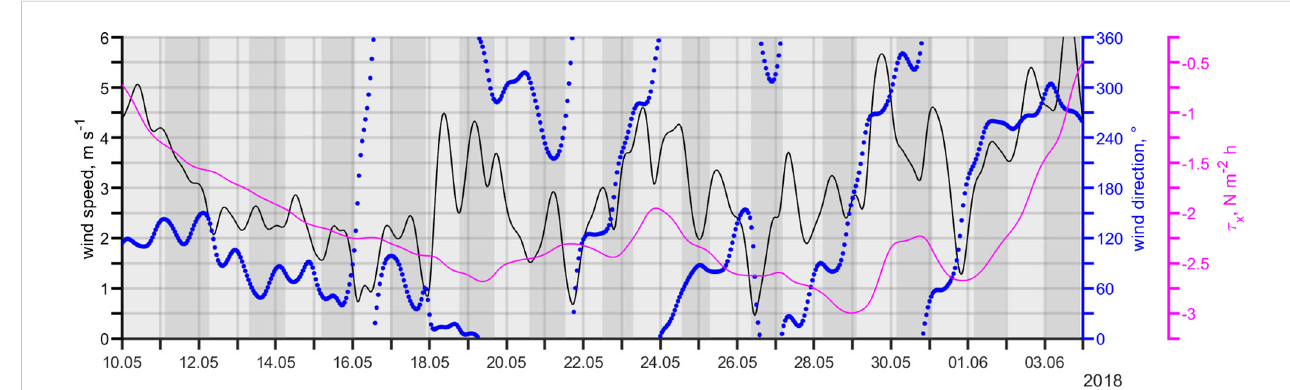
FIGURE 2 Wind forcing during the study period in May – June 2018 based on hourly data extracted from ERA5. Wind speed is shown in black and direction in blue, and cumulative wind stress in magenta. Shadowing indicates the orientation of the glider (light shows movement to N and dark to